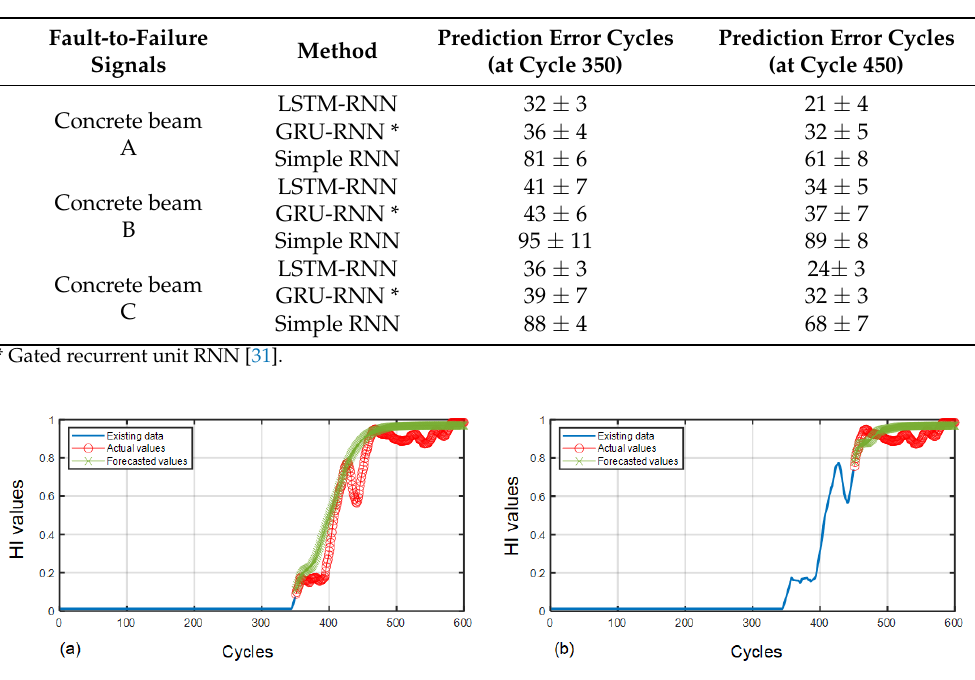
Table 3. RUL prediction results.